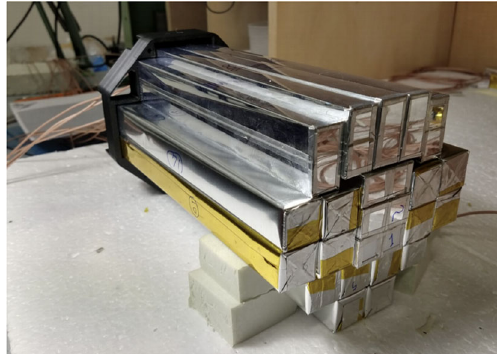
Fig. 4 Lower module of the BDX-MINI